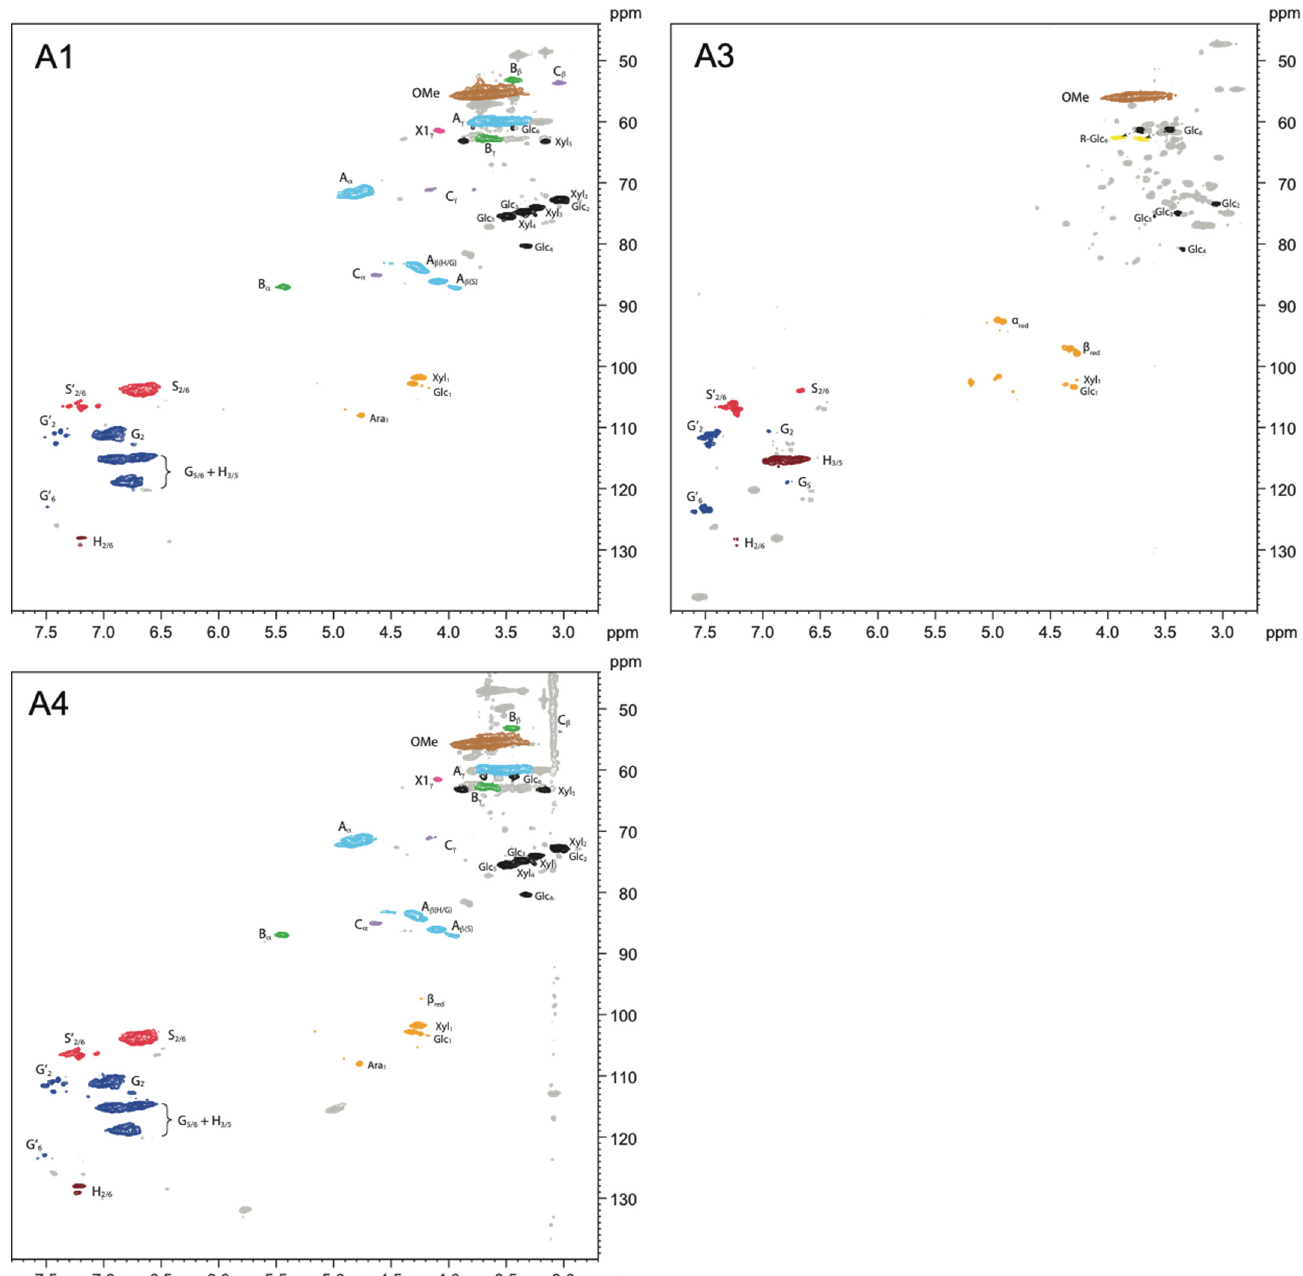
Figure 4. Partial 2D NMR spectra of alkoxysilane-treated wood showing the effects of the treatment with methyltrimethoxysilane ( A1 ), (3-mercaptopropyl)trimethoxysilane ( A3 ), and (3-thiocyanatopropyl)trimethoxysilane ( A4 ). The colored contours and labels correspond to the chemical structures shown in Figure 3.